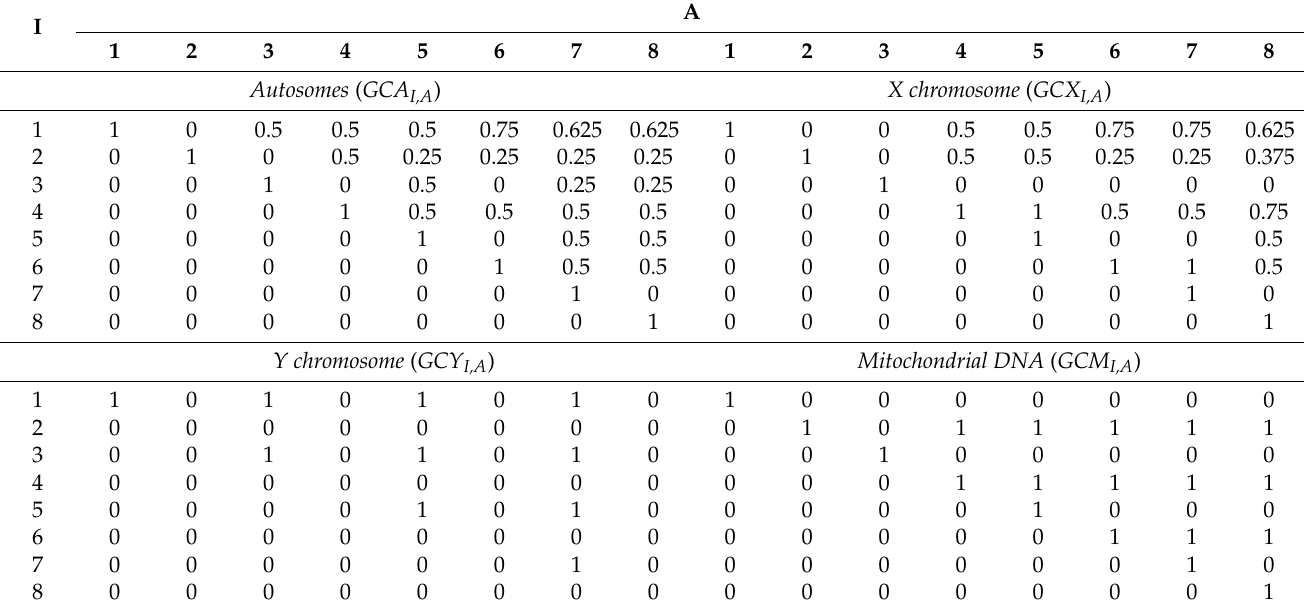
Table 3. Values of genetic contributions of individual I to individual A ( GCA I,A , GCX I,A , GCY I,A , and GCM I,A ) in Table